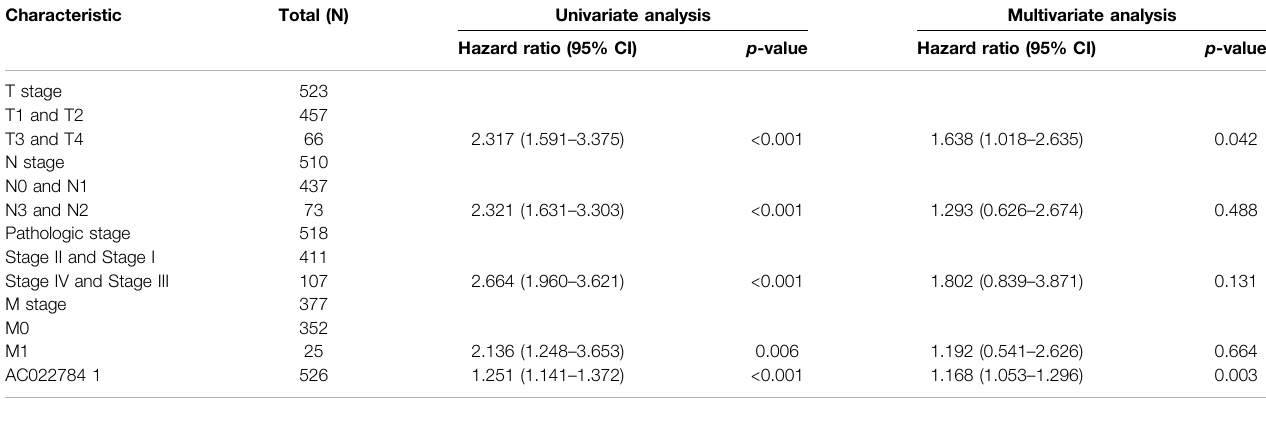
TABLE 1 | Univariate and multivariate Cox regression analyses of different parameters on overall survival in lung adenocarcinoma.